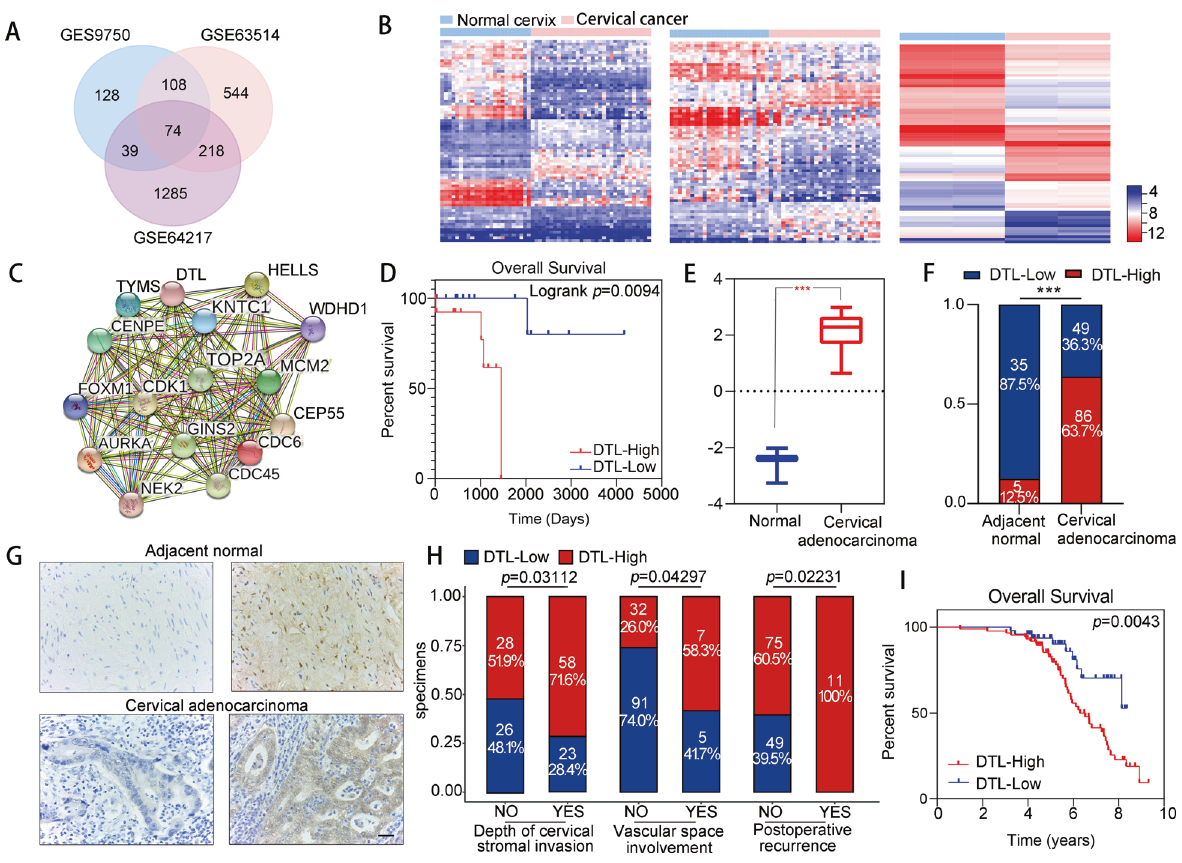
Fig. 1 Expression of DTL in cervical cancer data sets and its prognostic importance in patients with cervical adenocarcinoma. A Venn diagrams of DEGs in three gene expression data sets. B Heatmaps generated using the 74 common DEGs among the three data sets. C Signi fi cant module in the PPI network constructed from STRING using the common DEGs with MCODE scores = 15.467. D Overall survival of patients with cervical adenocarcinoma through the TCGA database ( n = 28, P = 0.0094, log-rank test). E Boxplot of DTL expression in normal and cervical adenocarcinoma groups of TCGA samples. F , G Staining rate of DTL and representative images of DTL immunochemistry in adjacent normal tissue and cervical adenocarcinoma tissue (magni fi cation, ×400). H DTL expression was signi fi cantly interrelated with the depth of cervical stromal invasion, vascular space involvement, and postoperative recurrence. I Overall survival of patients with cervical adenocarcinoma was analyzed using Kaplan – Meier curves. Each patient was classi fi ed as having “ low ” or “ high ” DTL expression ( n = 135, log- rank test). Error bars indicate the mean ± SD of three independent experiments. Student ’ s t -test; * P < 0.05, ** P < 0.01, *** P <